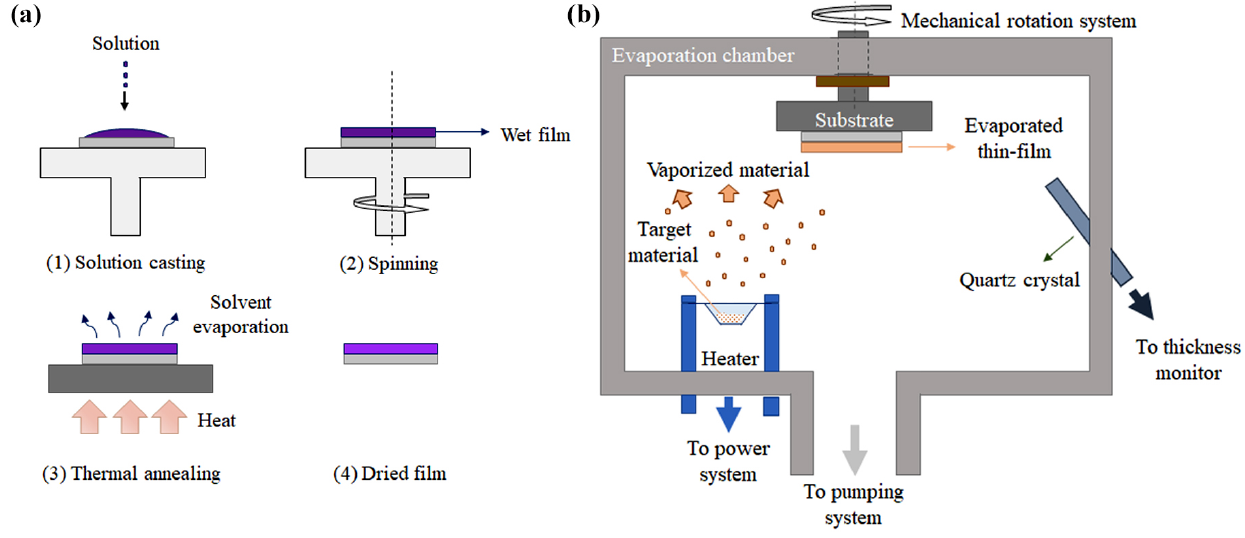
Figure 5. Illustration of well-established and pioneering techniques for thin-film deposition of organic electronic devices: ( a ) spin coating and ( b ) thermal